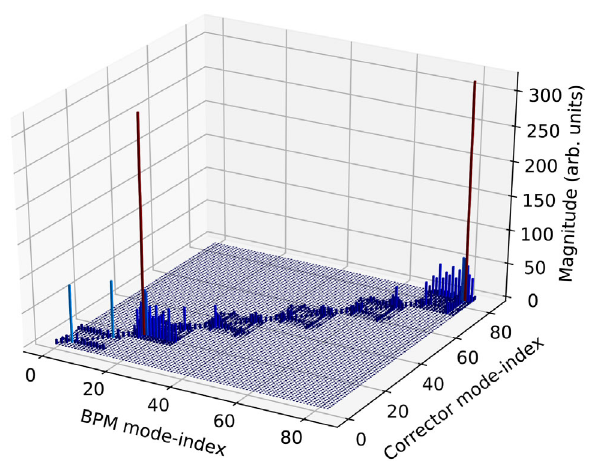
FIG. 4. Beta function at BPM locations in the y plane of SIS100 (simulated in MAD - X ) plotted for three cells, with beta beating [red line (star)] and without beta beating [blue line (times)]. The abscissa is the distance along the